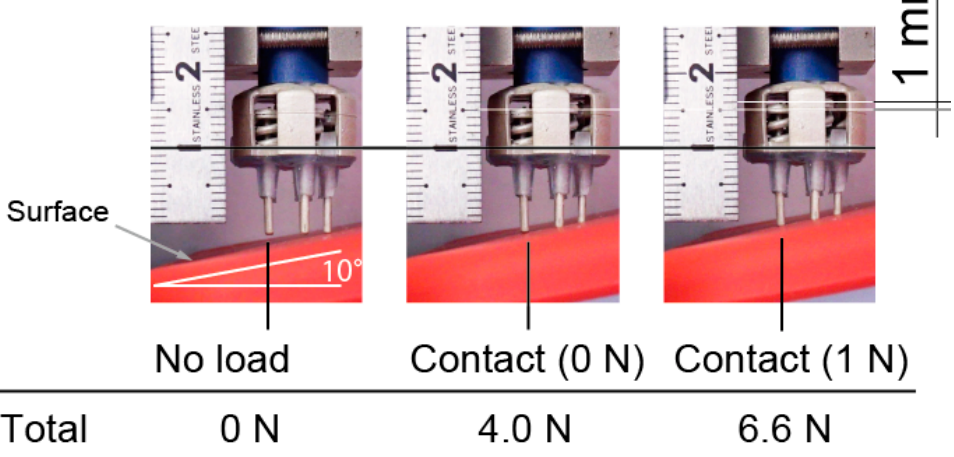
Figure 8. Vertical motion of prongs of electrode. All prongs were in contact with surface, and contact force was in design range.